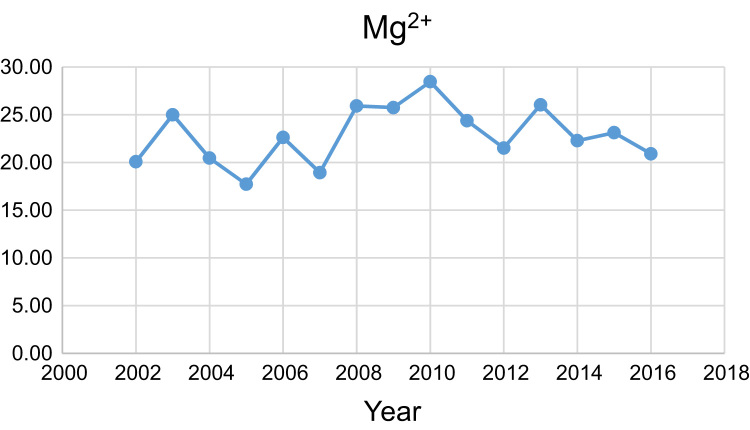
Mg2+ trend for groundwater in Abhar city.